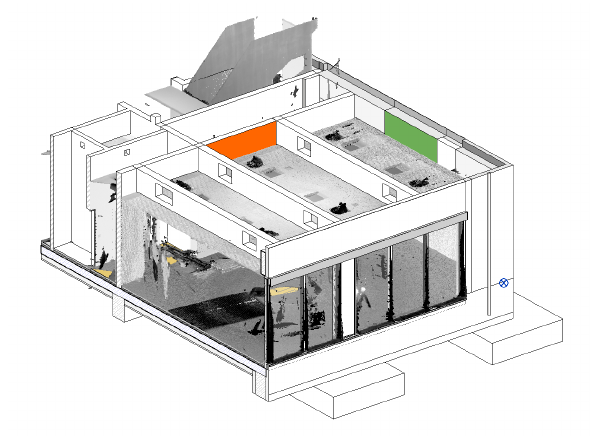
Figure 7. BIM model with finished co-registered point cloud cloud is not distorted in itself, but positioned as best as possible between the planes. Please note that the maximum residual is approximately 2.5 centimeters which complies with the expec- ted deviation between BIM Model and execution of construc- tion work. If the models did not fit to the scanned reality, the co-registration would be biased. However, this would be docu- mented in the protocol.